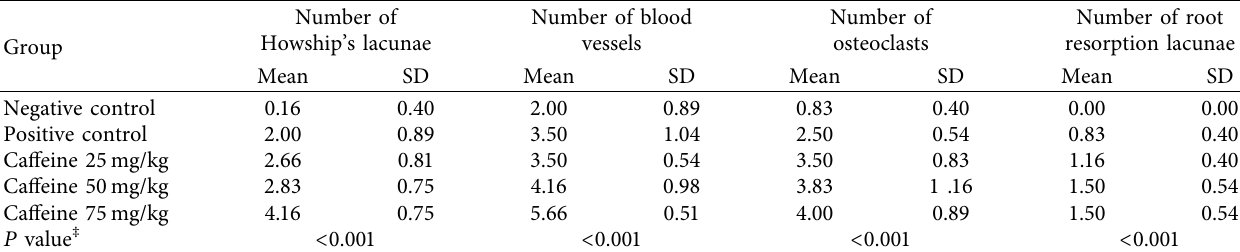
Table 2: The mean and standard deviation of each histologic variable in the experimental groups (mm 2 ). Number of Number of blood Number of Number of root Howship’s lacunae vessels osteoclasts resorption lacunae Group Mean SD Mean SD Mean SD Mean SD Negative control 0.16 0.40 2.00 0.00 Positive control 2.00 0.89 Caffeine 25 mg/kg 2.66 0.81 Caffeine 50 mg/kg 2.83 0.75 Caffeine 75 mg/kg